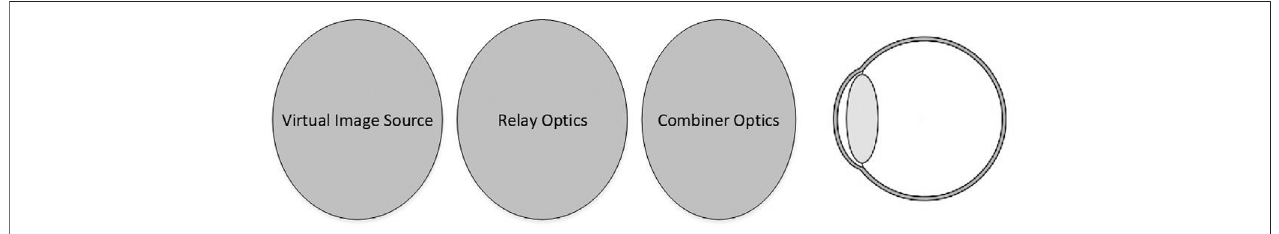
FIGURE1| Schematic diagram for basic components of optical see-through ARNED which includes: adisplay unit or image source (e.g., alaserprojector,aLCD display panel);magnifyingopticsorrelayopticsandthemedium totransmitandprojectthevirtual imageriesintotheeyesoftheviewerswhileallowingthelights fromthe real environment to pass through (e.g., half mirrors, holographic fi